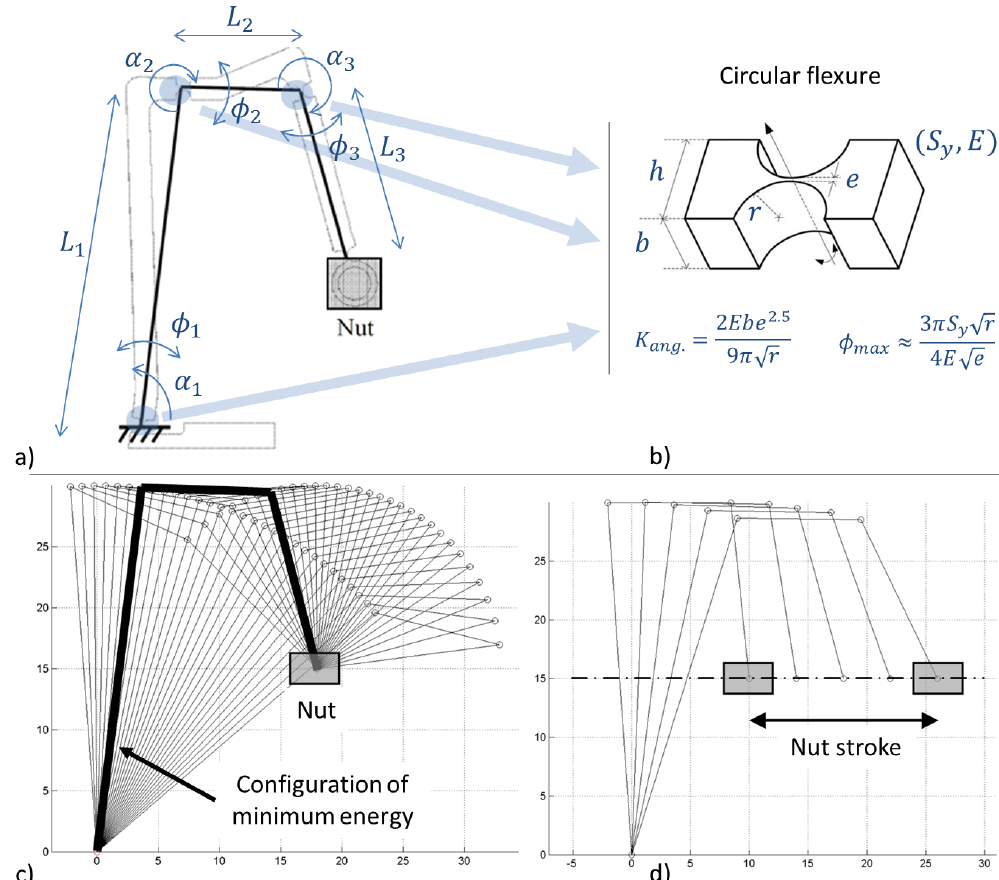
Figure 5. Basic principle of the compliant anti-rotation mechanism: ( a ) kinematics of the flexure-based three-bar linkage and its design parameters for optimization; ( b ) elementary circular flexure hinge joint; ( c ) configuration of minimum energy for a position of the nut; ( d ) successive mechanism configurations for the travel of the